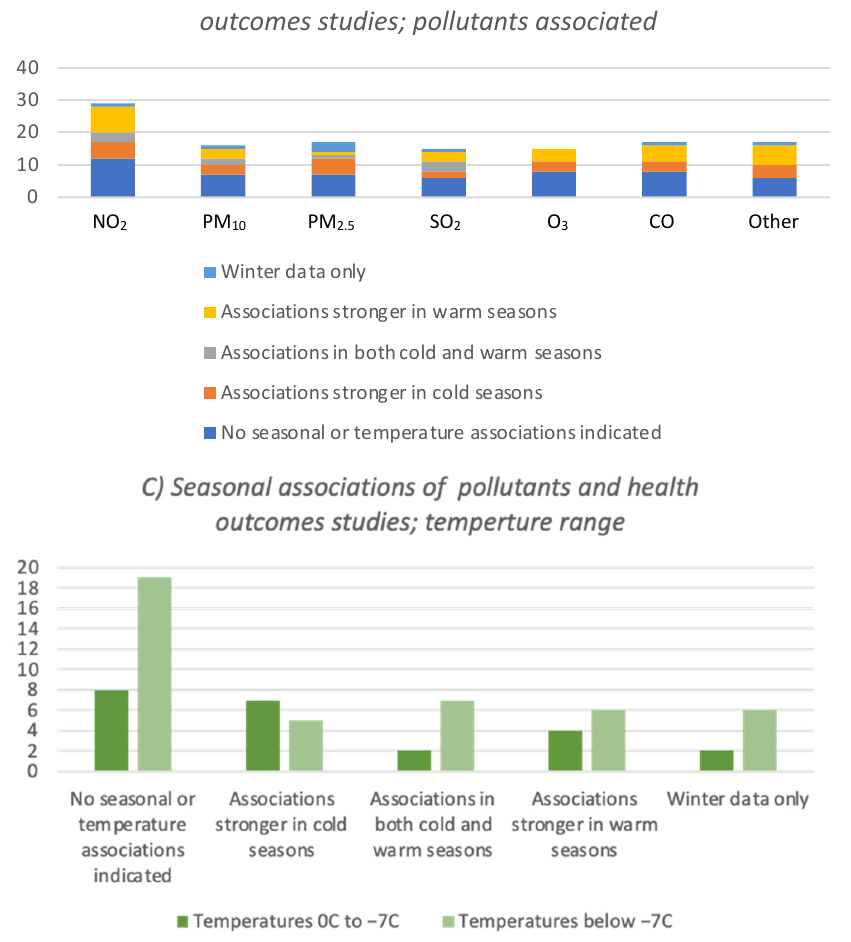
Figure 3. Pollution and health studies. Health outcomes with seasonal associations ( A ), the pollutants involved ( B ), and the temperature range reported ( C ). Legend: Blue = papers that used winter data only; yellow = papers that identified stronger associations with health outcomes in the warm seasons; gray = papers that identified strong associations with health outcomes in both warm and cold seasons; orange = papers that identified stronger associations with health outcomes in the cold season; blue = papers that did not identify seasonal associations with health outcomes; dark green = 0 °C to − 7 °C; light green = below − 7 °C.